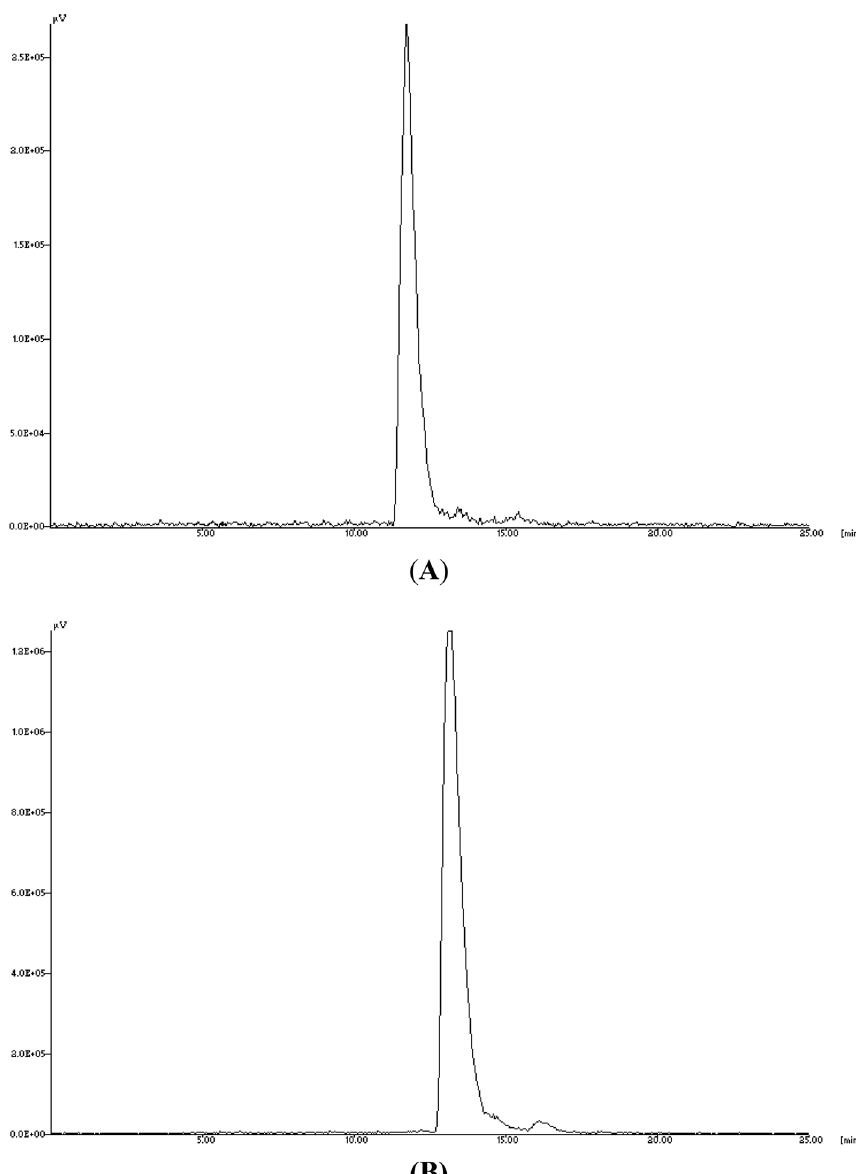
Fig. 1 HPLC chromatograms of ( A ) 64 Cu-NOTA- and ( B ) 64 Cu-NOTAM rhodamine